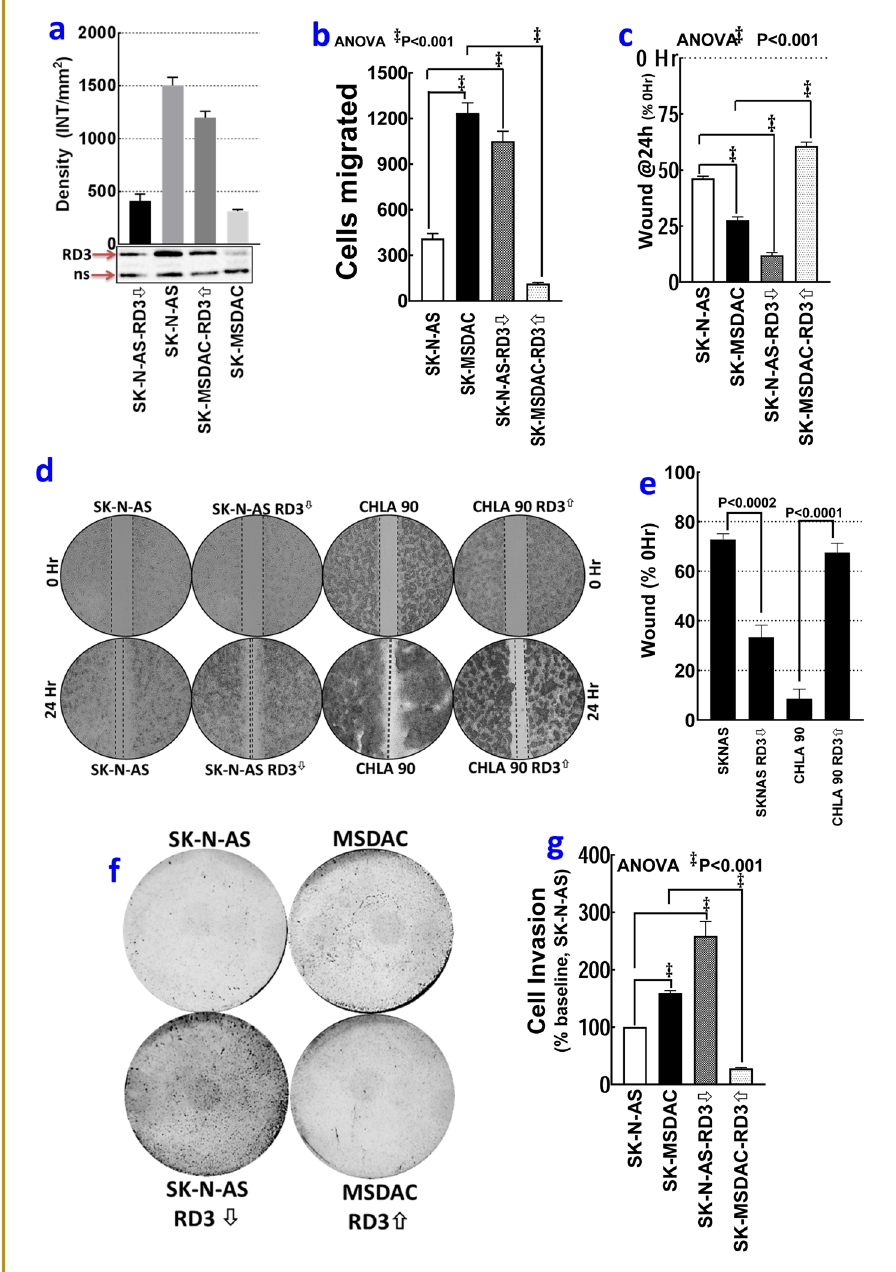
Figure 6. RD3 loss in the pathogenesis of progressive disease (PD): ( a ) Immunoblots showing the re-expression of RD3 in SK-MSDAC and silencing of RD3 in SK-N-AS cells. Full-length blots are presented in Supplementary Fig. S5. ( b ) Histograms from ORIS cell migration analysis exhibiting robust cell migration of SK-MSDACs and RD3-silenced SK-N-AS ( vs . parental SK-N-AS). Re-expression of RD3 in SK-MSDACs completely regulated the heightened migration capacity of SK-MSDACs. ( c ) Histograms of scratch wound gap measurements (mean and SD ) showing the cell migration patterns of SK-MSDACs, with and without RD3 re-expression, and parental SK-N-AS cells, with and without RD3 silencing under proliferation controlled conditions, examined at 24 h after wound initiation. SK-MSDACs exhibit robust cell migrations with significant wound closure after 24 h, while re-expression of RD3 in MSDACs significantly inhibited their migration. Silencing RD3 in SK-N-AS cells consistently increased their migration with significant wound closure. ( d ) Microphotographs and ( e ) histograms of scratch wound gap measurements (mean and SD ) showing the cell migration patterns of stage 4 MYCN-na patient derived PD cell-line CHLA-90 (that displayed high RD3-loss), with and without RD3 re- expression. SK-N-AS cells, with and without RD3 silencing were used as assay controls. CHLA-90 exhibit robust cell migrations with significant wound closure after 24 h, while re-expression of RD3 significantly inhibited their migration. ( f ) Photographs of Matrigel invasion assay showing robust invasion of SK-MSDACs, completely alleviated invasion in RD3-re-expressed SK-MSDACs, and a profound increase in the invasive potential of